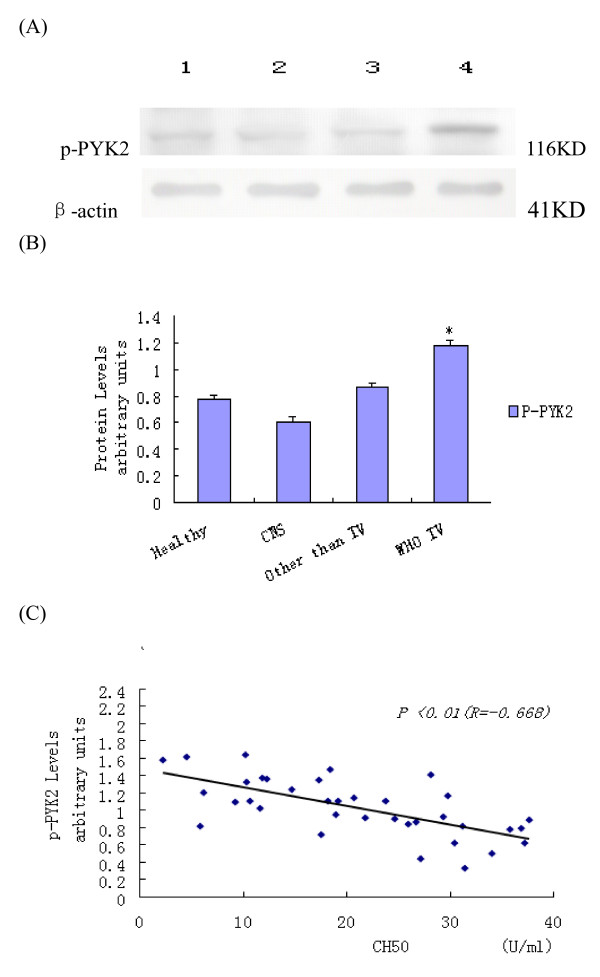
(A) Activation of PYK2 in PBMCs from healthy donors (n = 24) and SLE patients with central nervous system (CNS) disease (n = 6), WHO class IV nephritis (n = 29), or nephritis other than WHO class IV (n = 19). Total proteins obtained from PBMCs lysates were examined by Western blotting analysis for p-PYK2 as indicated in patients and methods. Lane 1, healthy donors;Lane 2, SLE patients with central nervous system; Lane 3, lupus nephritis other than WHO class IV;Lane 4, lupus nephritis IV. (B) The ratio between the optical density of specific bands and β-actin of the same sample was calculated and expressed graphically. The experiments for each sample were repeated at least three times and bars represent the mean and standard deviation of three separate experiments. Statistical comparison of all groups was made with healthy donors. The significance level was set at* = P < 0.05. (C) Correlation between PYK2 activation in PBMCs and serum levels of CH50 in SLE patients (n = 36).